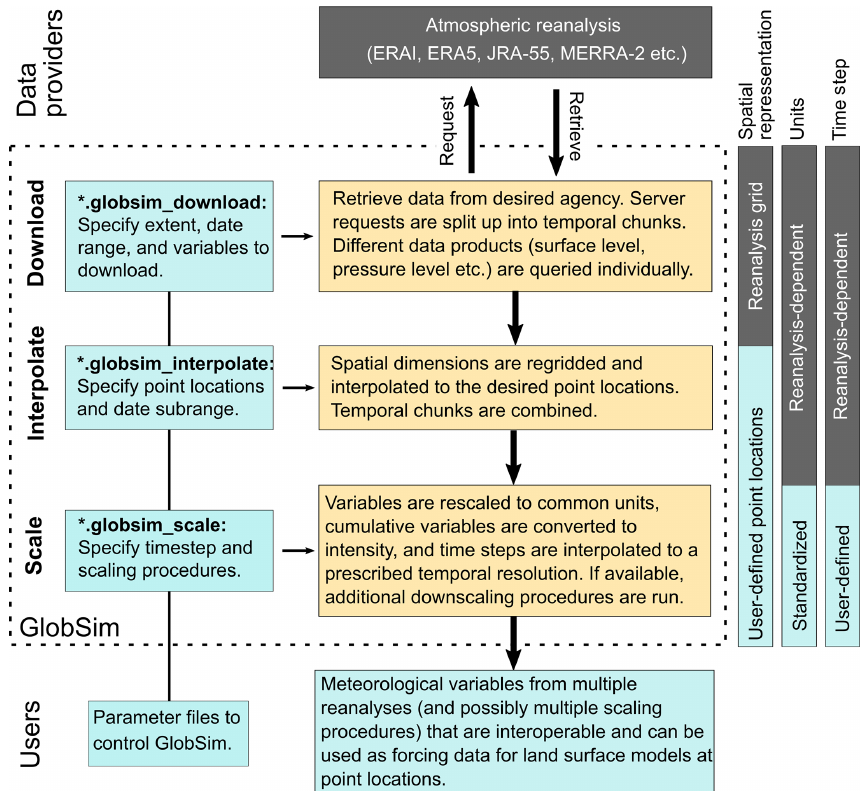
Figure 1. GlobSim schematic: reanalysis data are processed in three main steps based on user-specified parameter files. The color of each